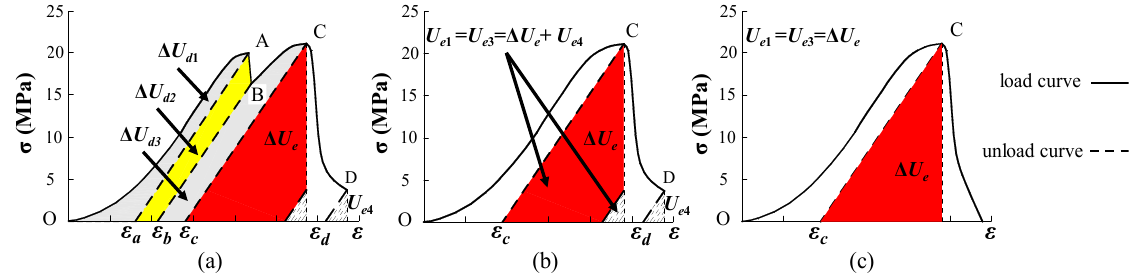
Figure 6. Degeneration of effective elastic strain energy rate index. ( a ) the stress–strain curves for coal samples with pre-peak stress-drops and a certain amount of residual strength in the post-peak stage; ( b ) the stress–strain curves for coal samples with pre-peak non-stress drop and ( c ) the stress–strain curves for coal samples with post-peak non-residual strength.